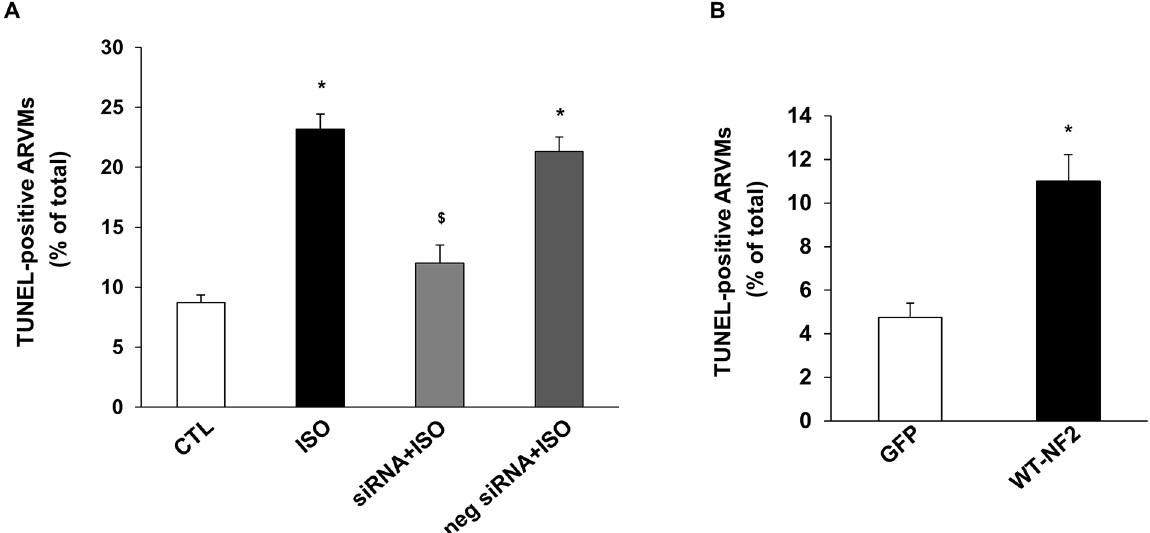
Fig 8. Knockdown of NF2 inhibits β -AR-stimulated apoptosis, while adenoviral-mediated expression of WT-NF2 induces apoptosis. (A) ARVMs were transfected with NF2 siRNA or negative control siRNA (neg siRNA) for 24 h followed by treatment with ISO for 24 h. Apoptosis was measured using TUNEL assay. (cid:3) p < 0.05 vs CTL; $ p < 0.05 vs ISO or neg siRNA+ISO; n = 3–4. (B) ARVMs were infected with adenoviruses expressing WT-NF2 or GFP for 48 h. Apoptosis was measured using TUNEL assay. (cid:3) p < 0.05 vs GFP; n = 3–4.